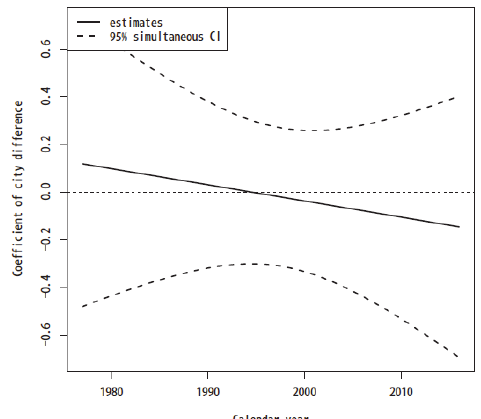
Fig. 2. Observed and predicted frequencies of "world"